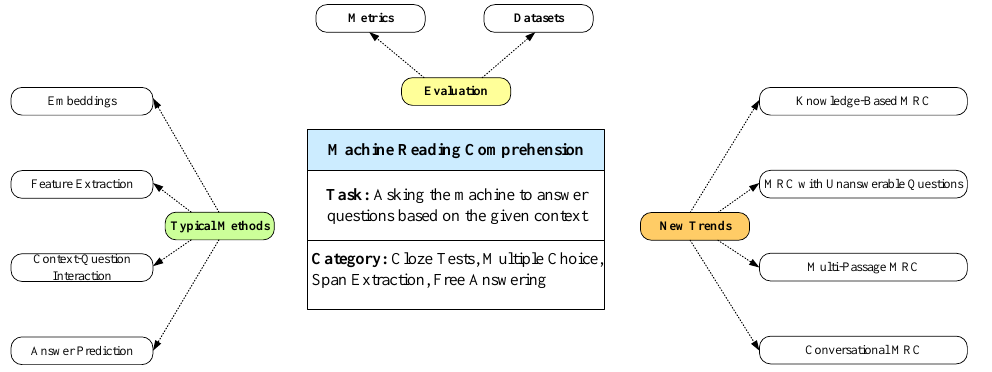
Figure 3. Facets of machine reading comprehension reflected in the structure of this